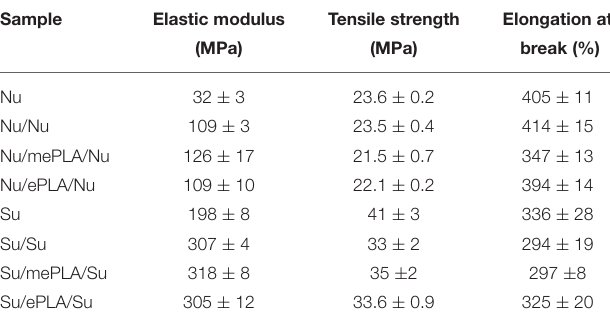
TABLE 2 | Mechanical properties of the processed